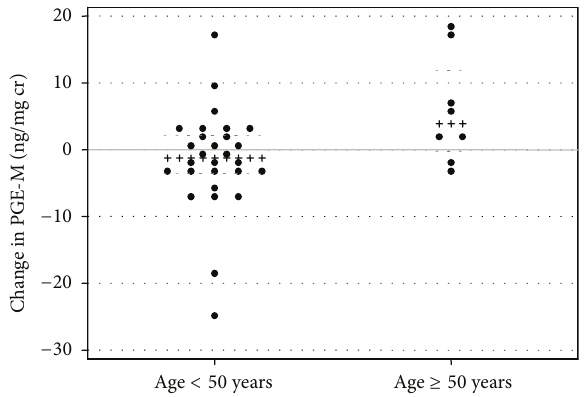
Figure 3: Scatterplot of 24-week change in urinary PGE-M by age < or ≥ 50 years. Between-group 𝑃 = 0.05 . Black (x) lines indicate within-group median; grey dashed (-) lines indicate within- group 25th and 75th percentiles. F 2 -IsoPs: F 2 -isoprostanes; PGE-M: prostaglandin E 2 metabolite; PGI-M: prostacyclin metabolite; TxB 2 : thromboxane B 2 . Units are ng/mg